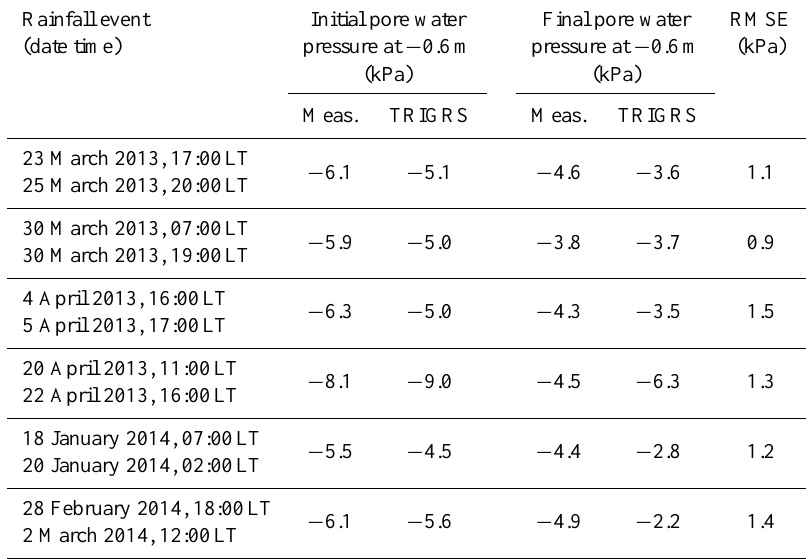
Table 7. Measured initial–final pore water pressure values versus those computed by TRIGRS-unsaturated for the selected rainfall events at 0.6m from ground corresponding to the monitoring station in the study area.